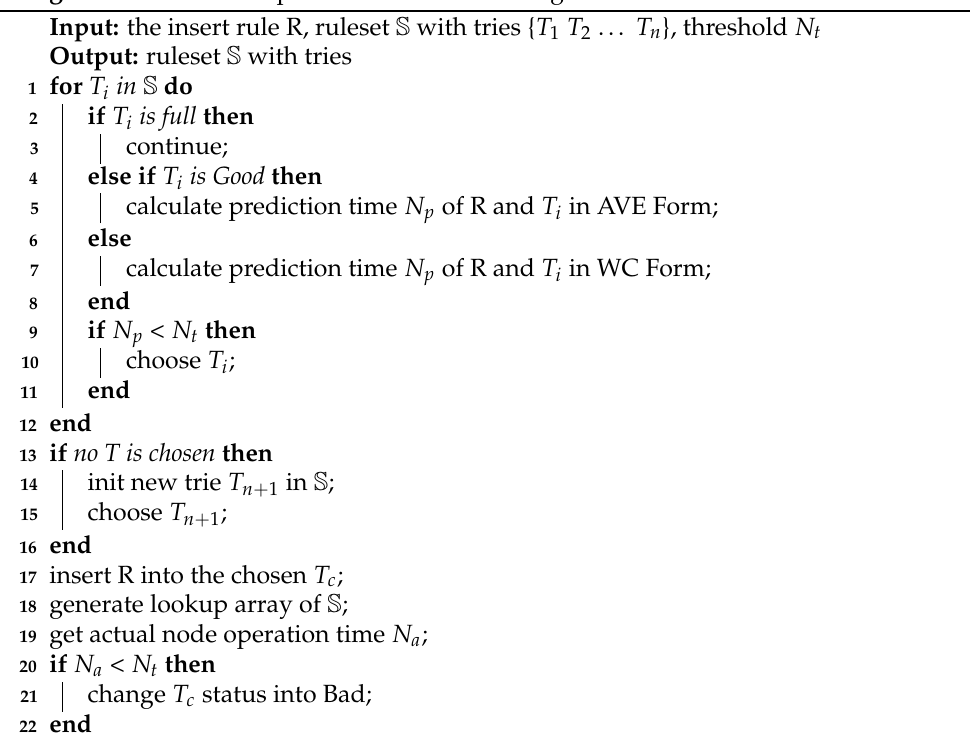
Figure 4. The update process of ITOC. Algorithm 1: Insertion process with trie